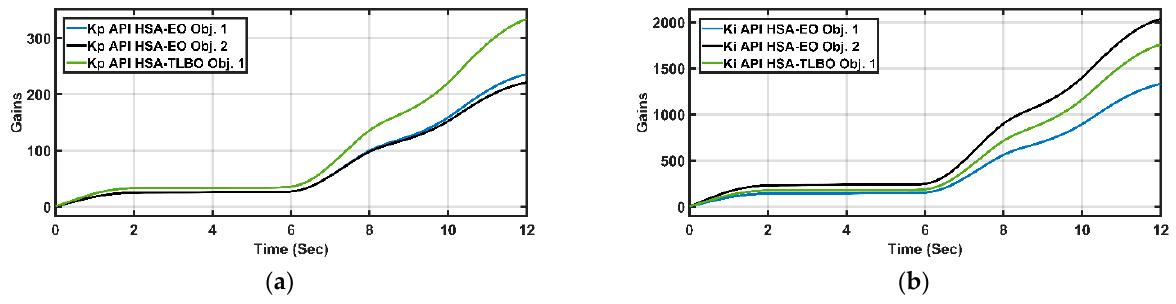
Figure 13. ( a ) (cid:1837) (cid:3043) adaptive PI gain of normal first case. ( b ) (cid:1837) (cid:3036) adaptive PI gain of normal first case. Figure 13. ( a ) K p adaptive PI gain of normal first case. ( b ) K i adaptive PI gain of normal first case.